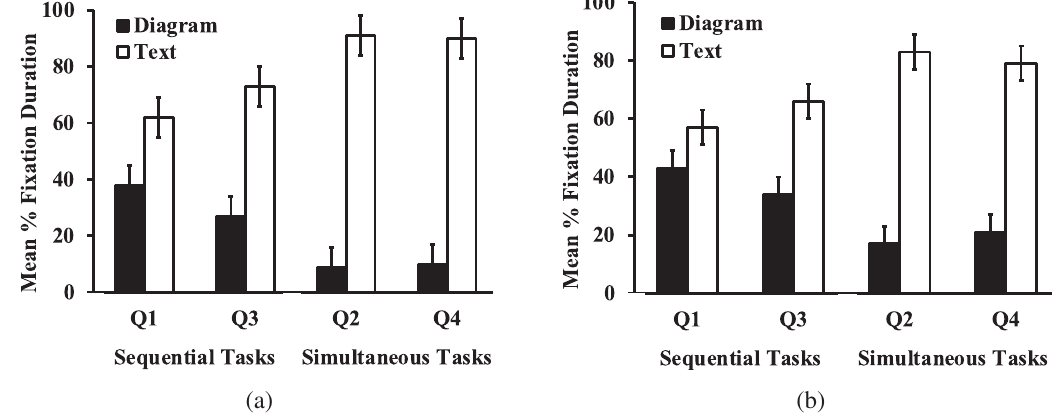
FIG. 3. Mean percentages fixation durations ( (cid:2) standard error) on diagram and text for (a) the thinking phase and (b) the talking phase across the four